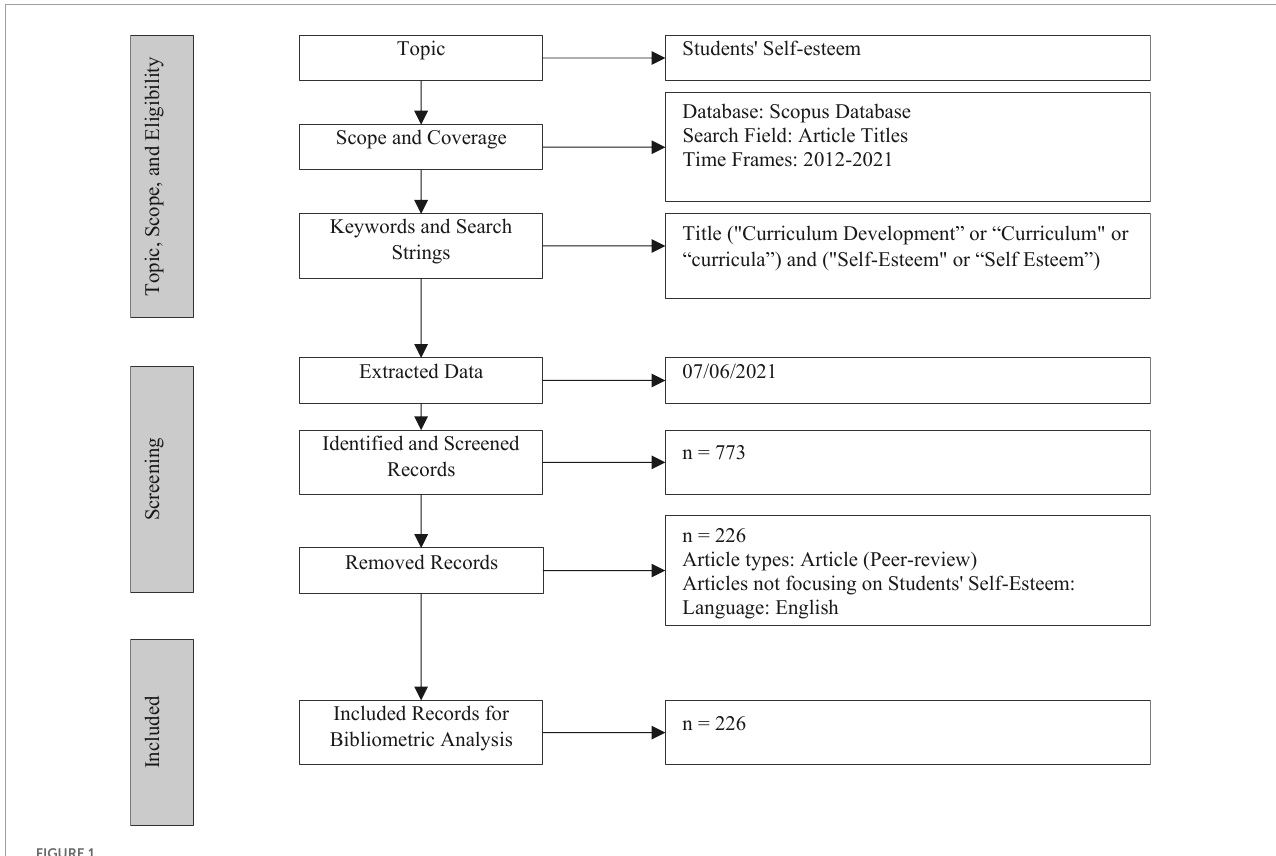
FIGURE1 Diagram of the PRISMA. PRISMA, preferred reporting items for systematic reviews and